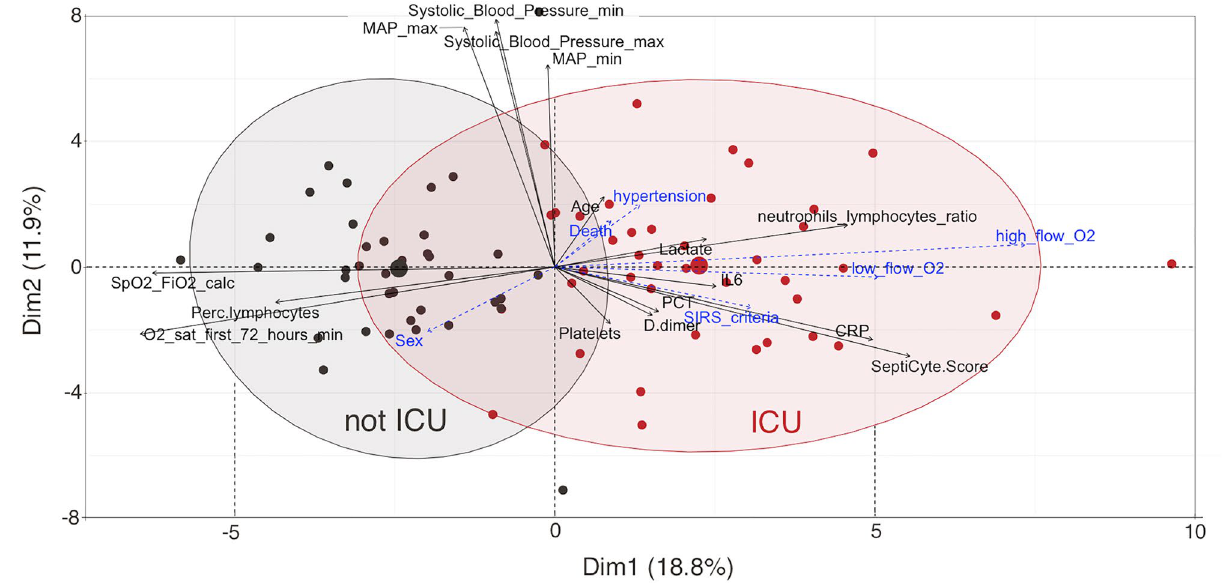
Figure 1. Principal Component Analysis (PCA) biplot, for separation of patients with ICU admission vs. non-admission. A total of 45 variables were used to define the dimensions (“eigenvectors”) of the PCA plot. A total of n = 77 patients were analyzed, representing critical and severe COVID cases that needed ICU admission (red points; N = 40) vs. mild and moderate cases that did not need ICU admission (black points; N = 37). These were the two maximally different groups within the study cohort. The variables shown with blue dotted arrows are supplementary continuous variables which did not contribute to the construction of the PCA dimensions, but which are presented to aid in the interpretation in the PCA biplot . Additional details are provided in Supplementary Table